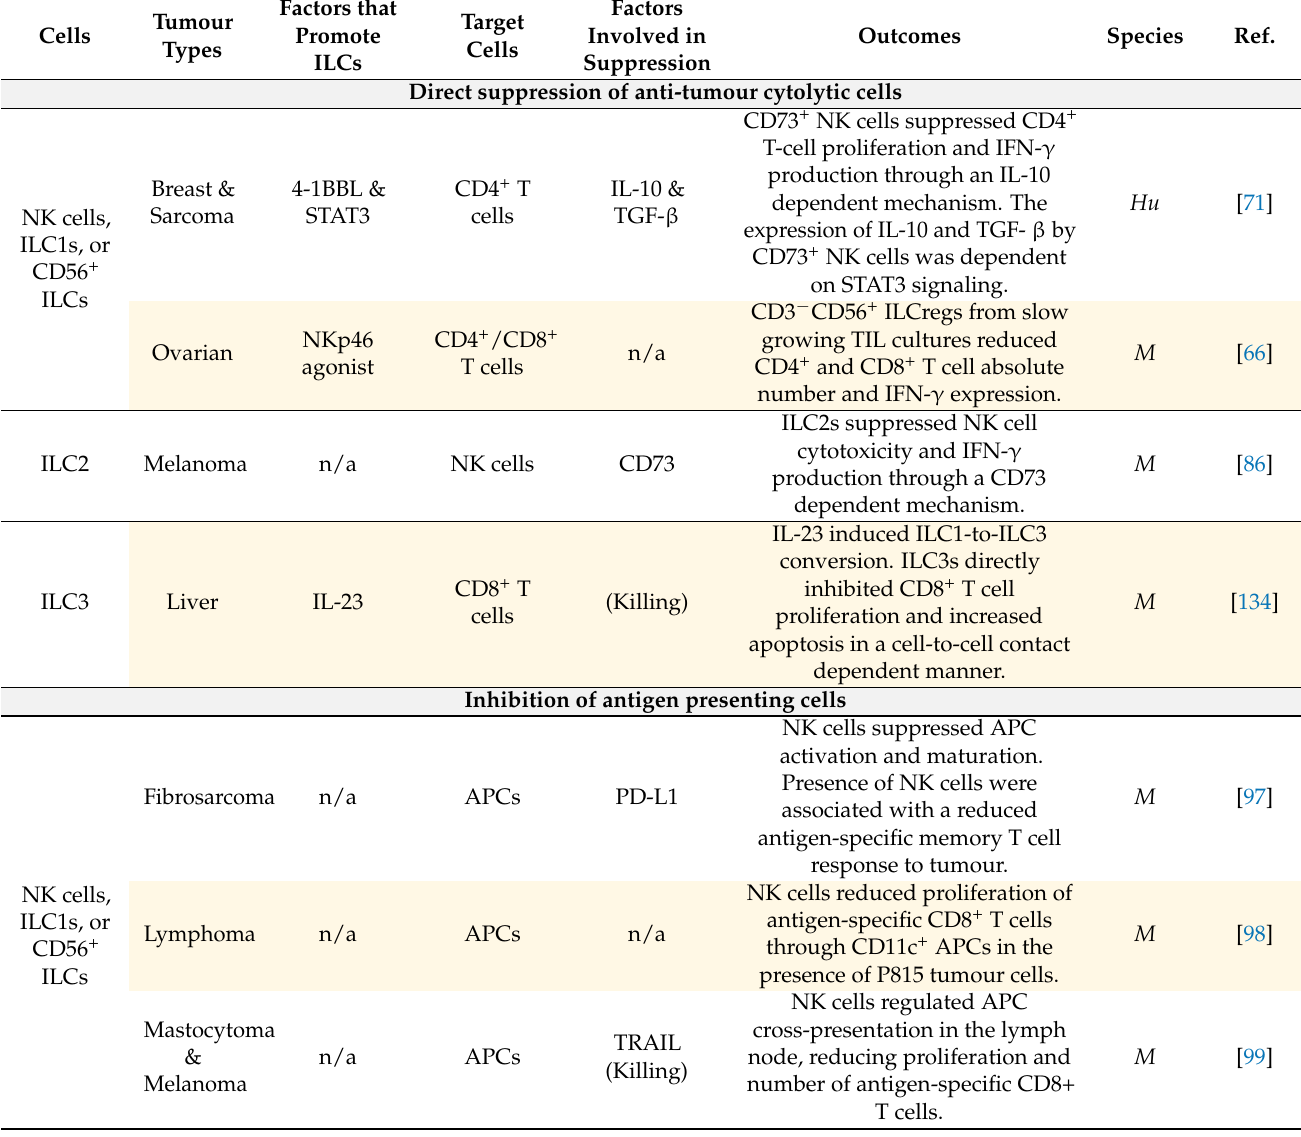
Table 1. Mechanisms of ILC-mediated immune suppression in